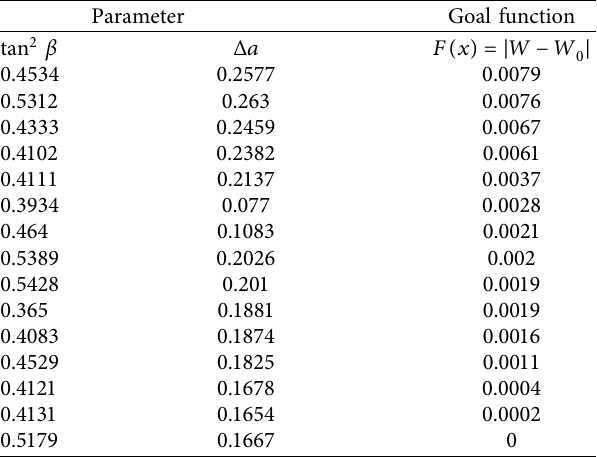
Table 3: Optimized FOA results.